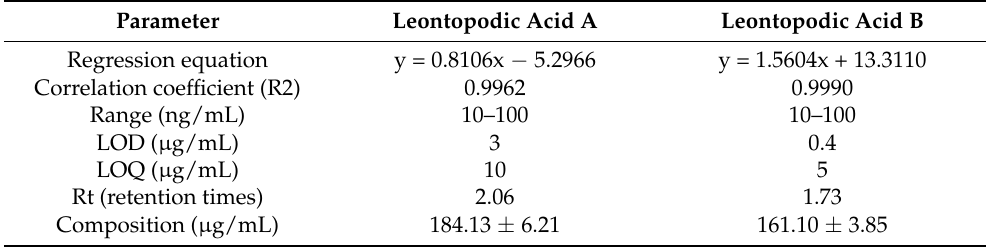
Table 2. Calibration data and sensitivity of